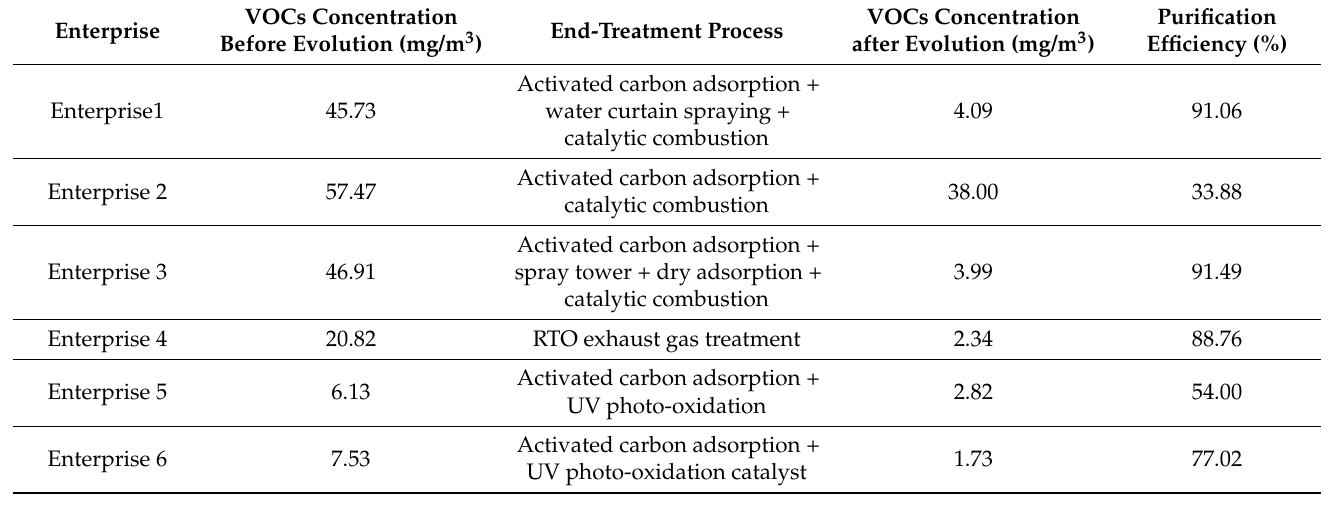
Table 2. End-treatment facilities, pre-treatment and post-treatment concentrations and corresponding treatment efficiencies of each enterprise.